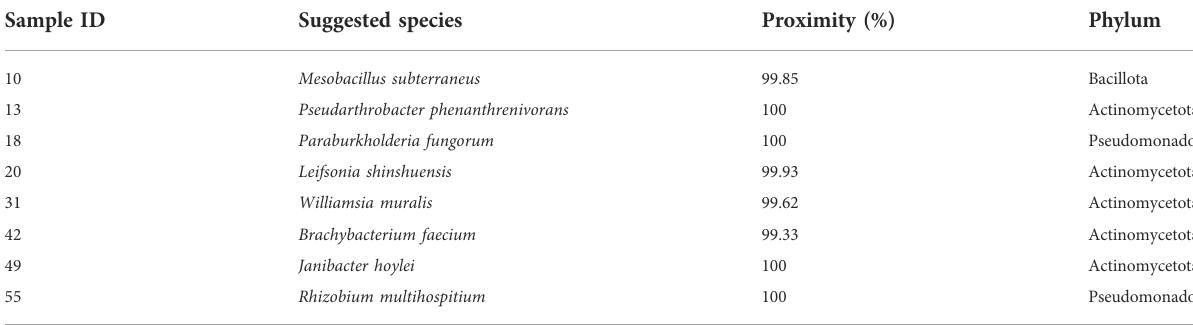
TABLE 2 Suggested species of selected isolates by consensus sequence BLASTed againt NCBI nucleotide database. Sample